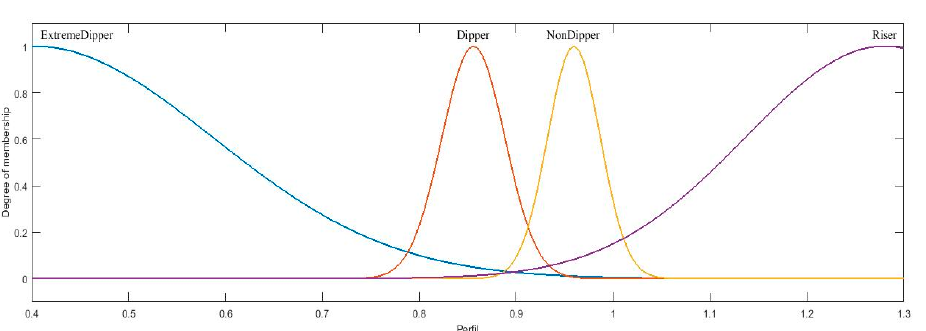
Figure 17. Nocturnal blood pressure level